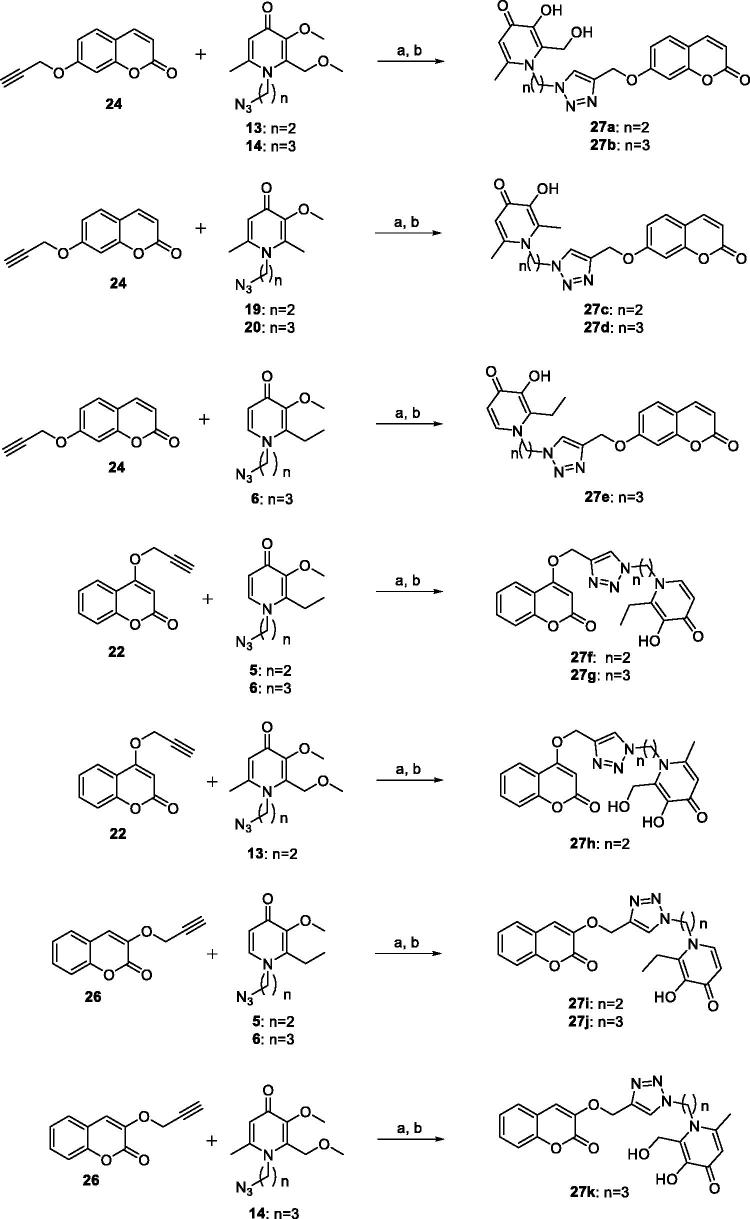
The synthetic route of compounds 27a-k. Reagents and conditions: (a) MeOH:H2O = 1:1, CuSO4·5H2O, sodium ascorbate, 25 °C, 2 h, 81%–92%; (b) CH2Cl2, BBr3, MeOH, 0 °C- r.t., 1 h, 87%–95%.